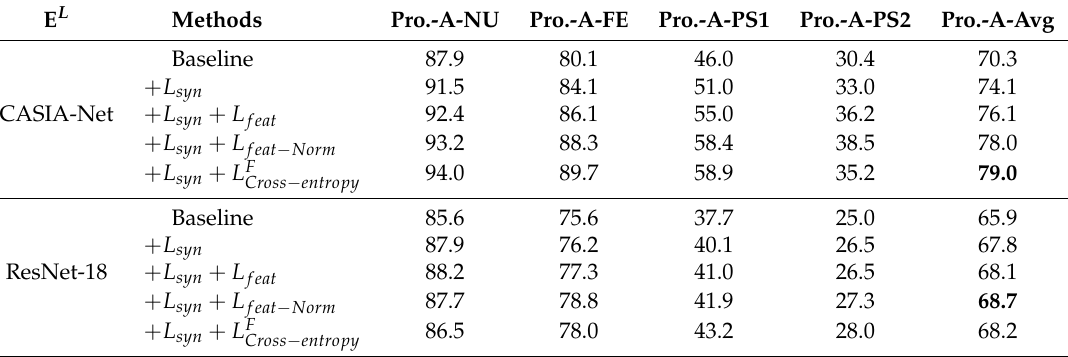
Table 7. Rank-1 identification rates (%) of image-based network in face recognition on low-quality data sets under variations. The results in ’Pro.-A-Avg’ are the average rates of specific methods, and the best accuracy is made